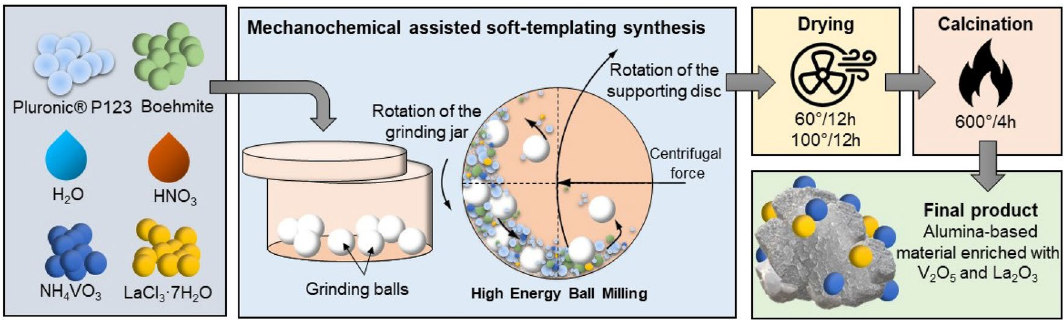
Figure 1. Schematic illustration of the applied synthesis